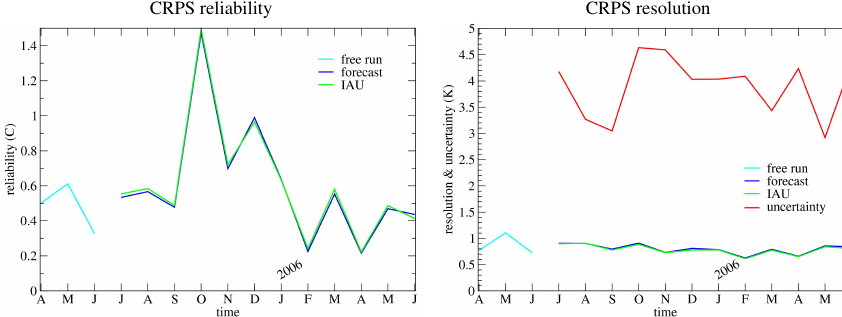
Figure 11. T profiles, reliability (left panel) and resolution components of the CRPS compared to the uncertainty (right panel). Table 3. Potential gain G compared to the uncertainty from July 2005 to June